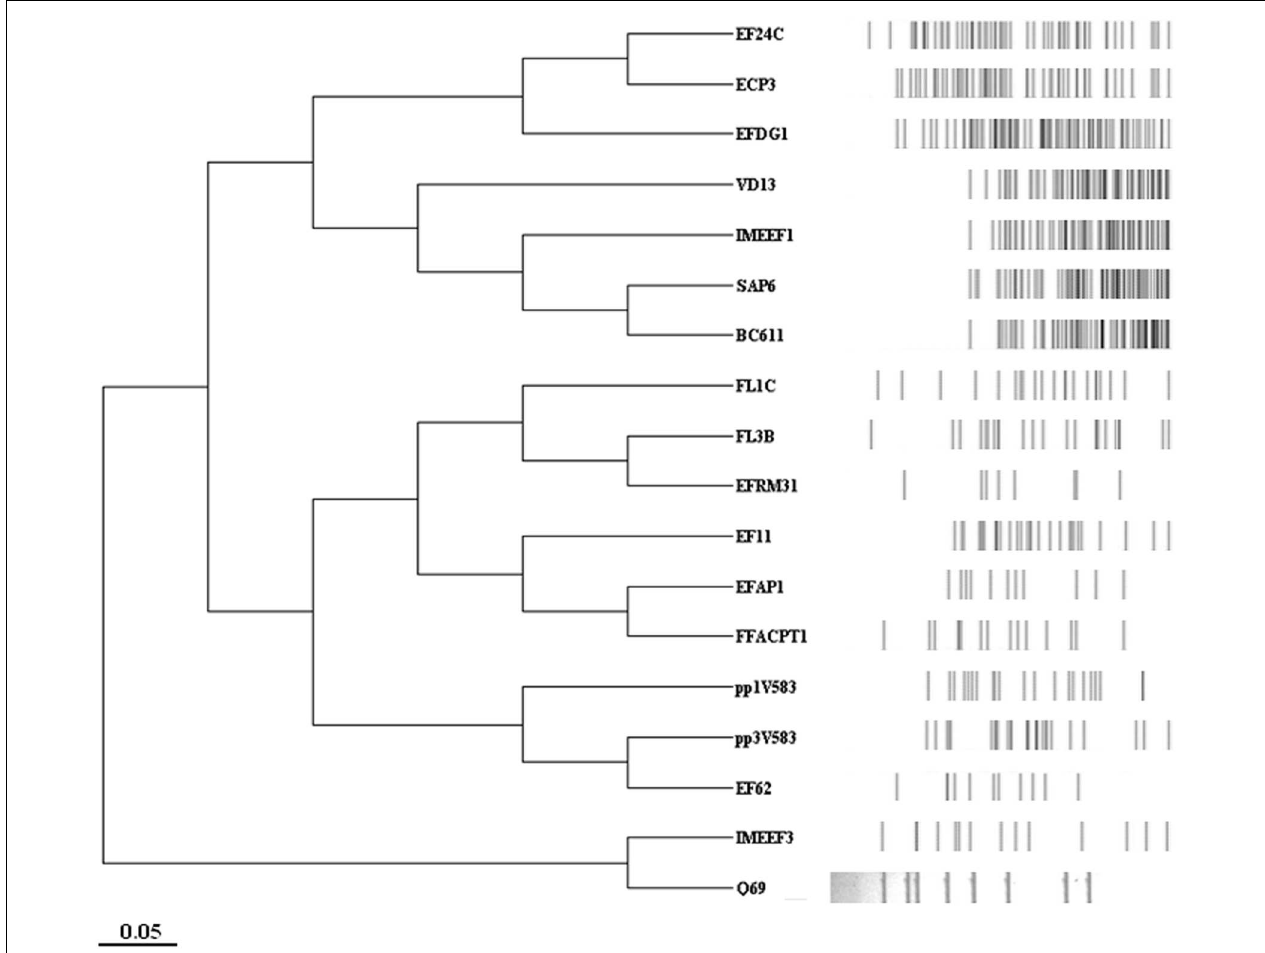
FIGURE 2 | Phylogenetic tree of Enterococcus faecalis bacteriophages. Phylogenetic analysis of the Hin dIII profile of virtually digested E. faecalis phage genomes available in databases. The name of each phage is shown (as represented in Table 2 ) as well as its Hin dIII restriction